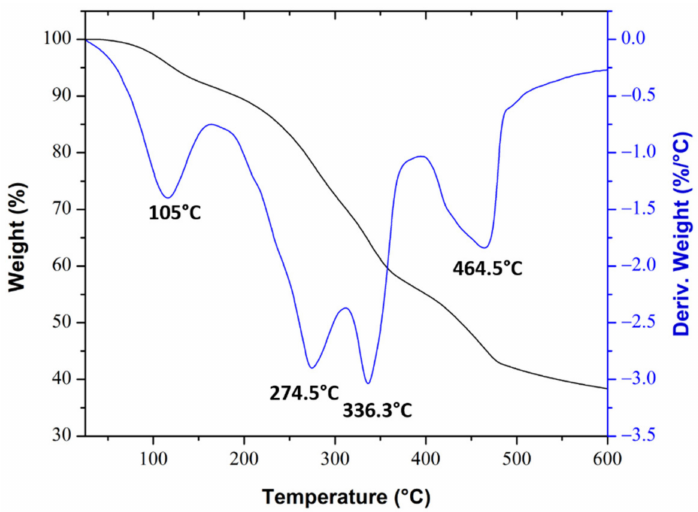
Figure 2. TG and DTG curve of carob